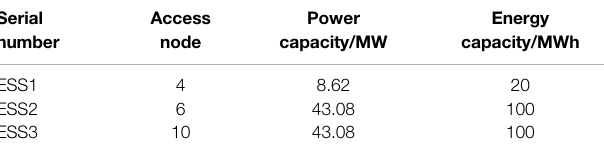
TABLE 2 | Optimization results of ESS capacity and locations in Scenario 3.